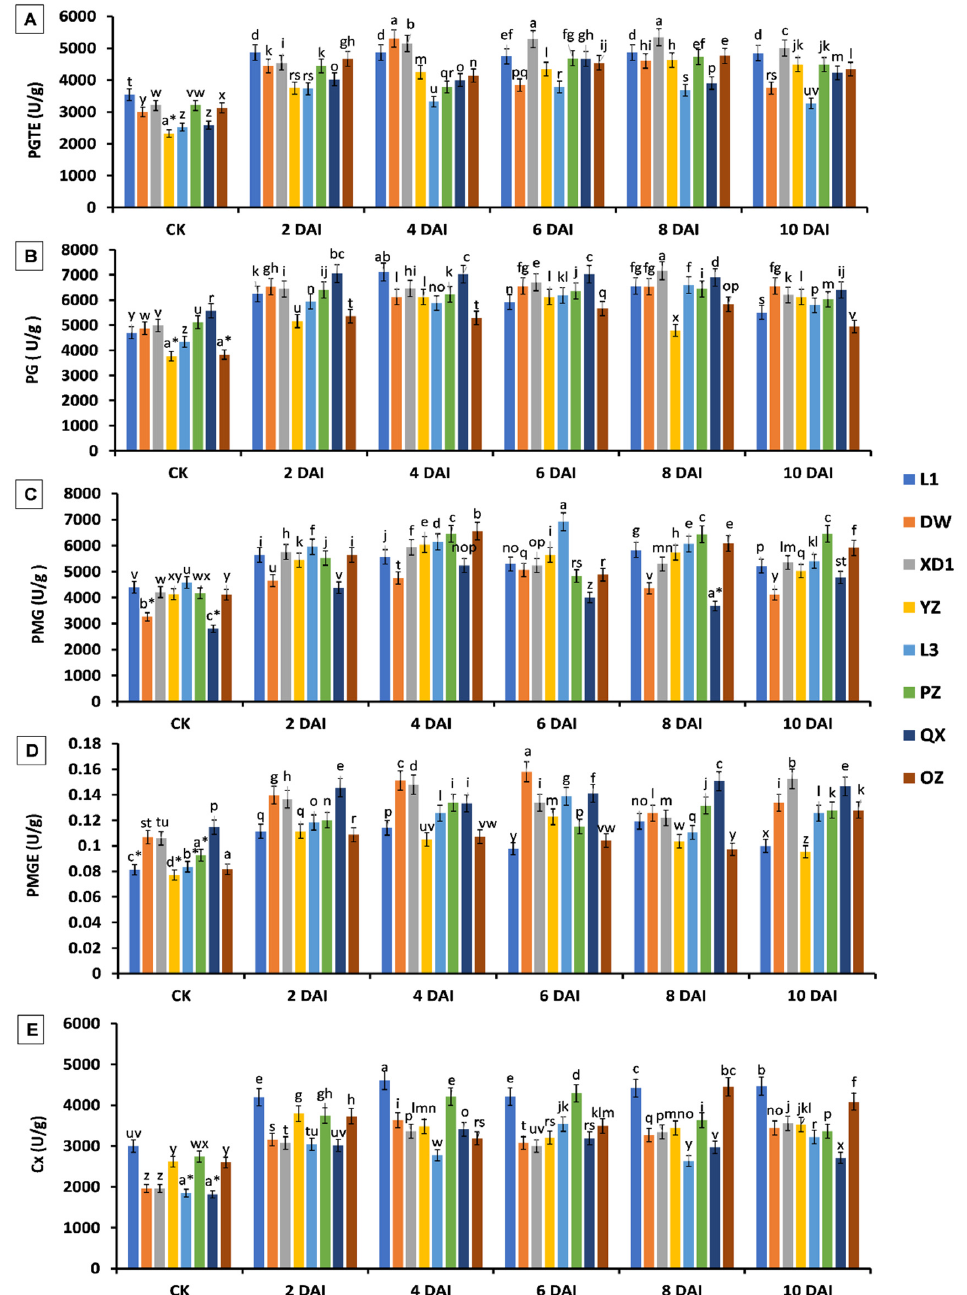
Figure 3. Cell membrane degrading enzyme activity analysis in eight hazelnut varieties (Liao 1 (L1), Dawei (DW), Xianda No. 1 (XD1), Yuzhui (YZ), Liao 3 (L3), Ping hazelnut (PZ), Qiuxiang (QX), European hazelnut (OZ)) on 2, 4, 6, 8 and 10 DAI of B. cinerea infection. ( A ) Polygalacturonase trans elimination enzyme (PGTE), ( B ) Polygalacturonase (PG), ( C ) Pectin methyl galacturonase (PMG), ( D ) Pectin methyl trans elimination enzyme (PMGE), ( E ) Carboxymethyl cellulase (Cx). Different letters above bars indicate significant difference at p ≤ 0.05. * Indicates the extended lettering, start- ing again from “a” after one set of alphabets (a-z) completed.